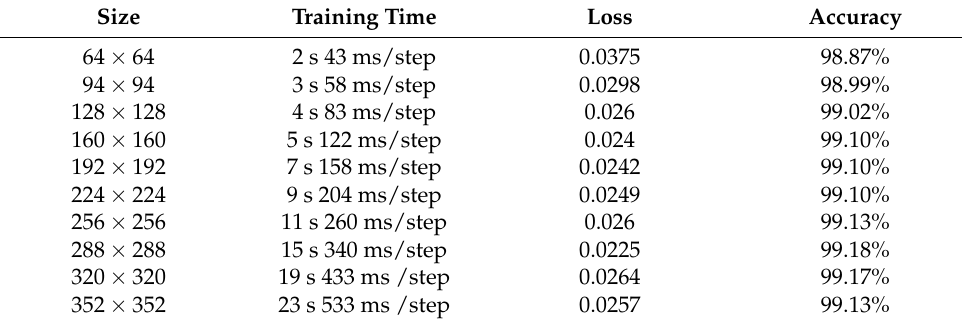
Table 2. Training results with different input